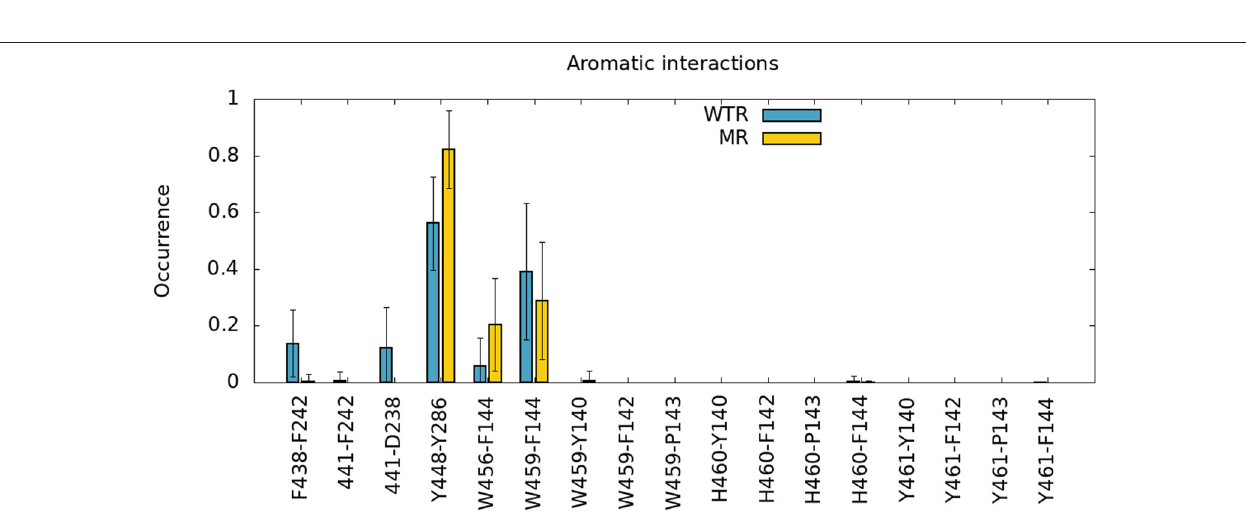
FIGURE 5 | π - π interactions (F438-F424,441-F242,Y448-Y286,W456-F144,W459-F144) and anion- π interactions (441-D238) of different amino-acids of M4, calculated over R01-400 for the WTR (blue) and the MR (yellow).